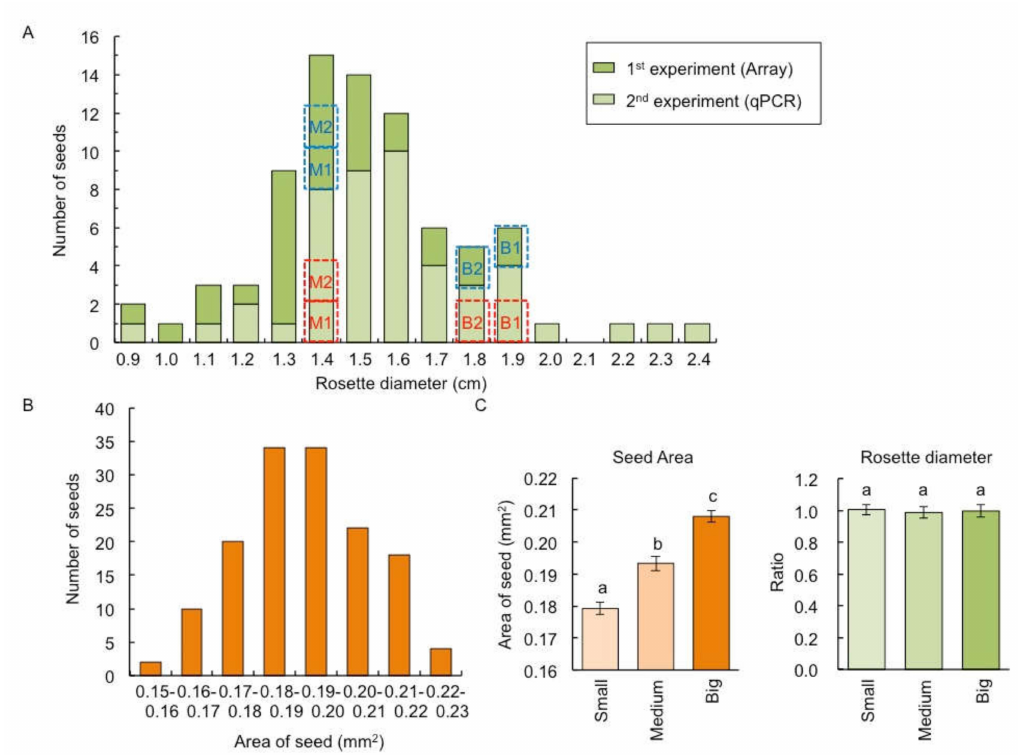
Figure 1. Variation of rosette diameter and seed size among individual F 1 plants between C24 and Columbia-0 (Col). ( A ) Distribution of rosette diameter among individual F 1 plants ( n = 80) at 14 days after sowing (DAS). Dark and light green bars represent plant materials used for microarray analysis and quantitative RT-PCR (qPCR), respectively. Blue and red dotted lines represent the plant size used for microarray and qPCR, respectively. ( B ) Distribution of seed area in F 1 ( n = 72). ( C ) The seed area (left panel) and rosette diameter at 14 DAS (right panel) derived from small, medium, and big seed fractions. The ratio of the rosette diameter compared with plants derived from big seed fractions are shown. Data presented are the average and standard error (s.e.) ( n = 9). Letters above the bars indicate significant di ff erences at p < 0.05 (Tukey–Kramer